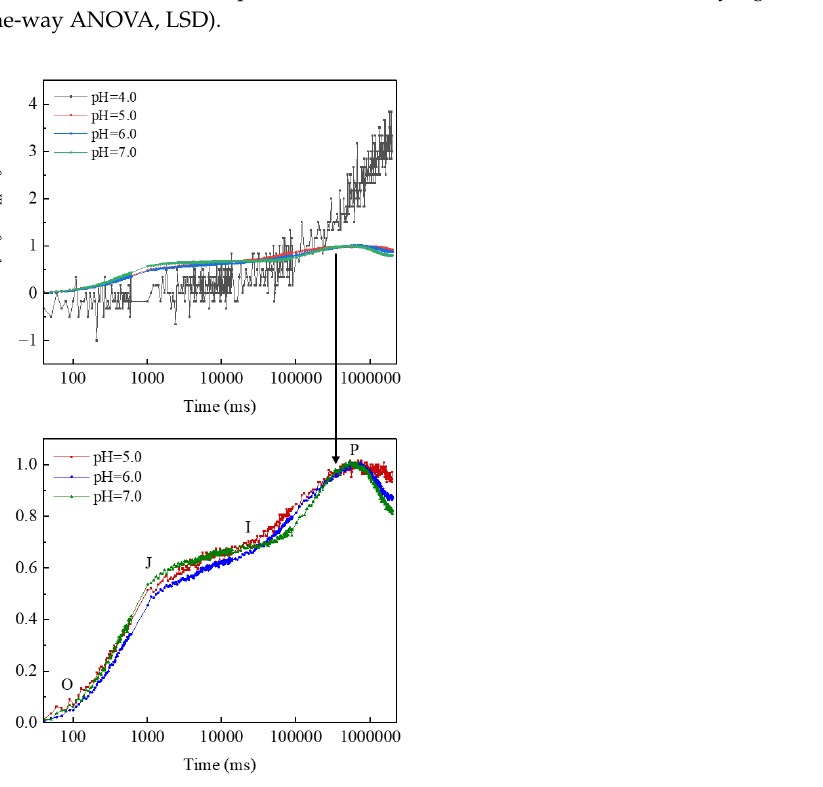
Figure 2. Effects of paddy floodwater acidification on the chlorophyll fluorescence transients of Aliinostoc sp. YYLX235.